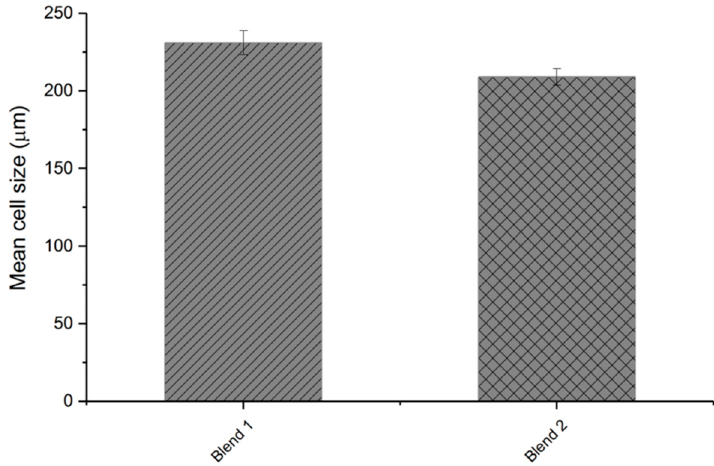
Figure 11. Mean cell size of foamed samples with pure talcum (blend 1) and modified talcum (blend 2).